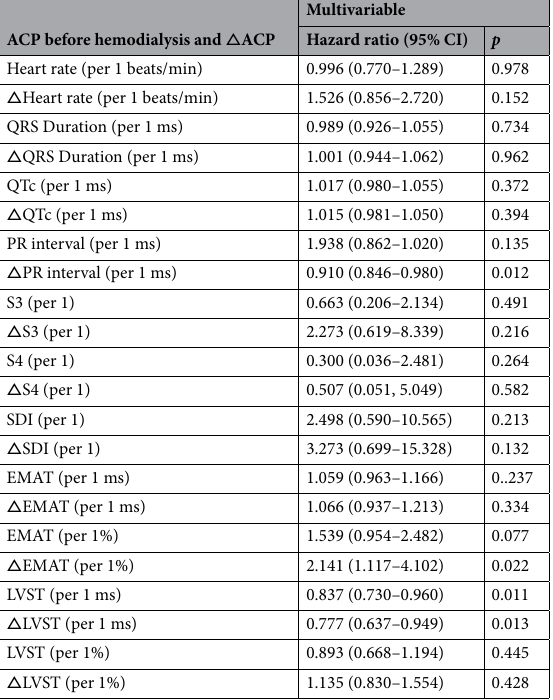
Table 4. Relation of acoustic cardiography parameters before hemodialysis and △ acoustic cardiography parameters to cardiovascular mortality. Values expressed as hazard ratio and 95% confidence interval (CI). Abbreviations are the same as in Table 1. Covariates in the multivariable model included age, sex, diabetes mellitus, hypertension, coronary artery disease, arteriovenous access type, dialysis vintage, systolic and diastolic blood pressures, albumin, log triglyceride, total cholesterol, hemoglobin, total calcium, phosphorous, CaXP product, potassium, uric acid, Kt/V, blood flow, and medications including ACEIs and/or ARBs, β-blocker, statin and